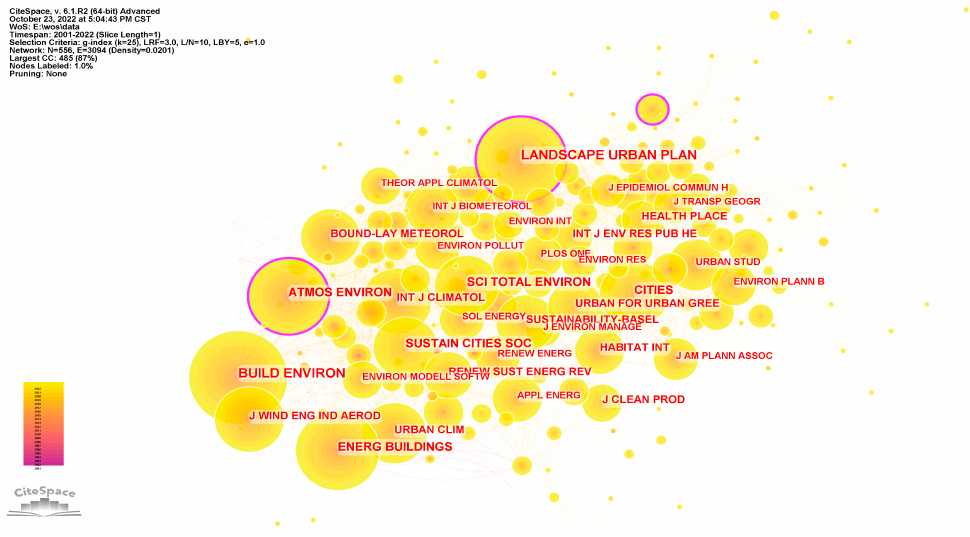
Figure 2. Publications on high-density city research from 2001 to 2022.